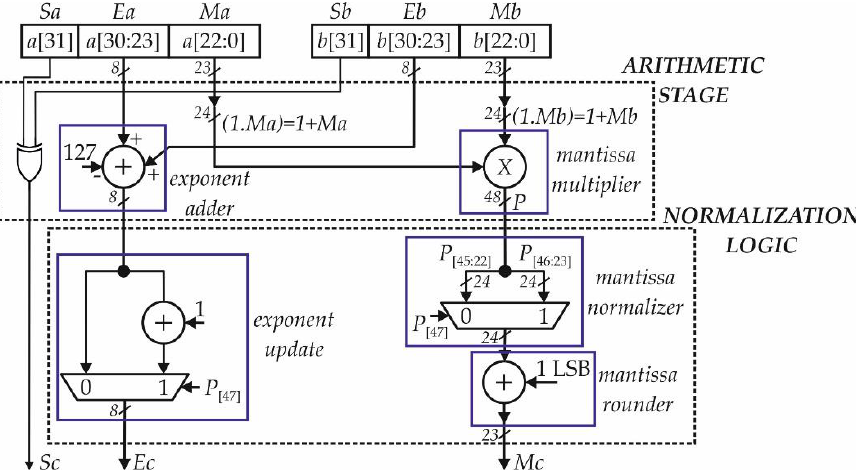
Figure 2. Block diagram of the single precision floating-point multiplier.